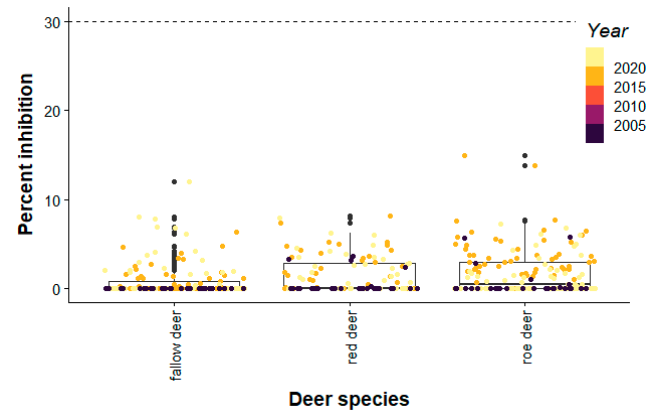
Figure 1. Results of the pseudoneutralization point assay are shown by year and deer species. Horizontal dashed line indicates the assay cutoff of the cPass SARS-CoV-2 Neutralization Antibody Detection Kit as 30% inhibition. A full multiple-sequence alignment of the ACE2 protein for the species is characterized in [7], and additional deer species are included from GenBank (GCA_000751575.1,